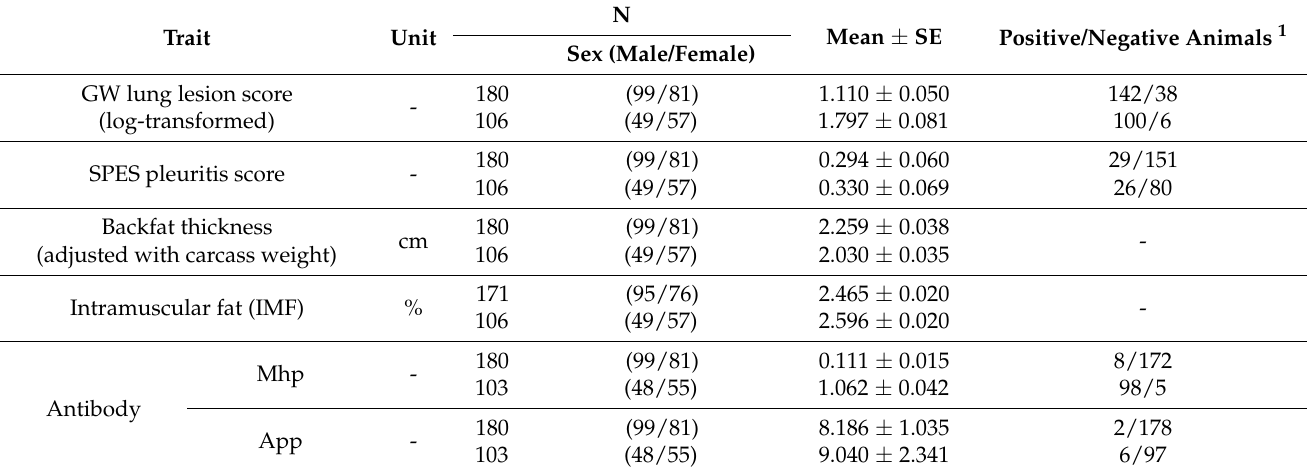
Table 1. Pig populations were used in this study. Upper and lower values correspond to farms A and B,